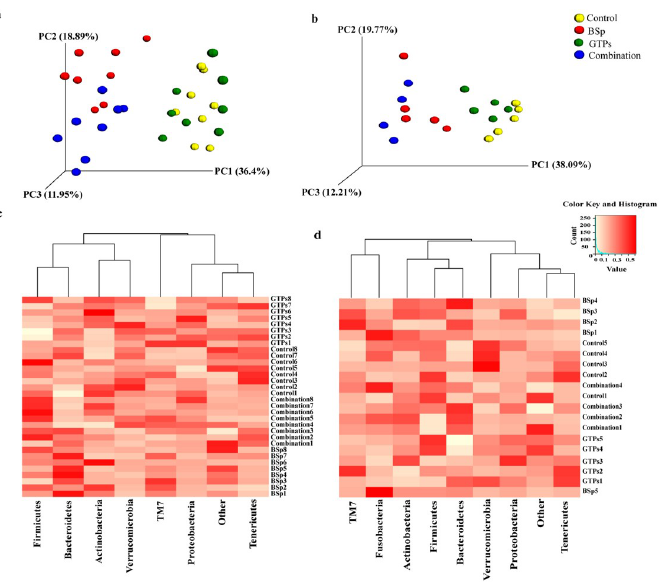
Fig 3. Taxonomic distribution of microbial communities in the gut of mice before the onset of tumor. (a) 3D PCoA plot (Bray Curtis) showing a distinct clustering of the BSp-fed (red) and combination-fed diet groups (blue) as compared to the control-fed (yellow) and GTPs-fed (green) in the BE group. (b) 3D PCoA plot (Bray Curtis) showing a distinct clustering of the control-fed (yellow), BSp-fed (red), GTPs-fed (green) and combination-fed (blue) diet groups in the LC group. PERMANOVA was used for conducting statistical analyses on association between microbial communities from the distance matrix of the Bray Curtis test of beta diversity by using R (v3.6.0). (c) Heatmap representing the pre-tumor phylum level changes in microbial abundance by our dietary treatments in the BE group. (d) Heatmap representing the pre-tumor phylum level changes in microbial composition by our dietary treatments in the LC group. Each row corresponds to differentially expressed microbial communities and each column represents biological replicates in the BE (n = 8) and LC (n = 5) treatment groups. White color denotes lower expression levels and red color denotes higher expression levels.